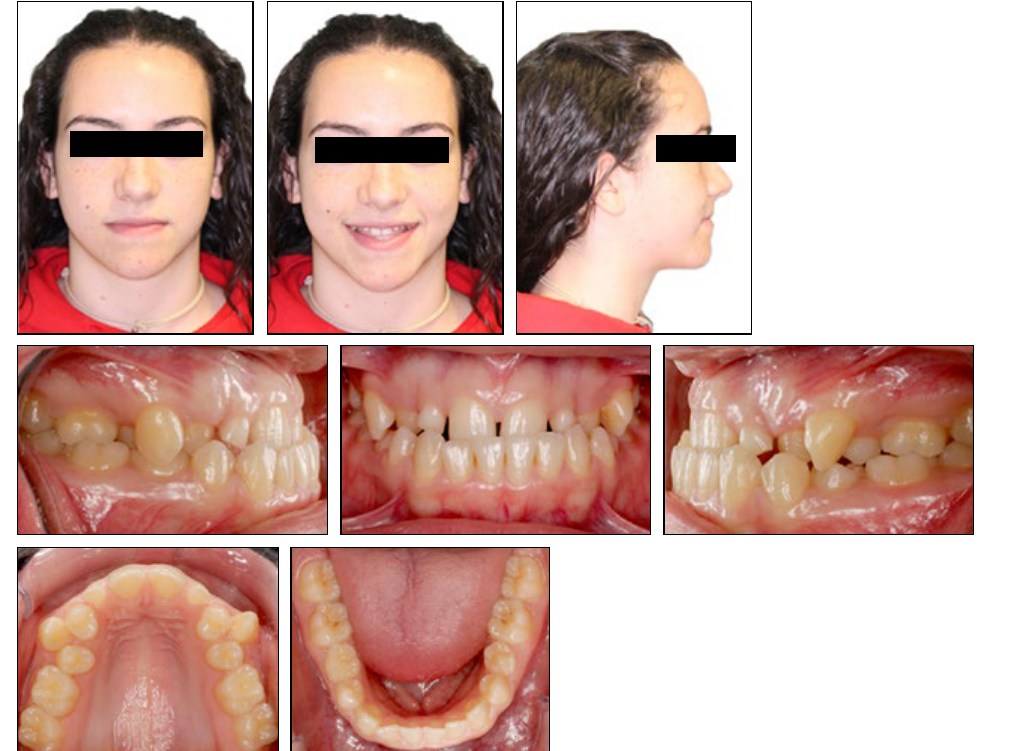
Figure 1. Pretreatment facial and intraoral